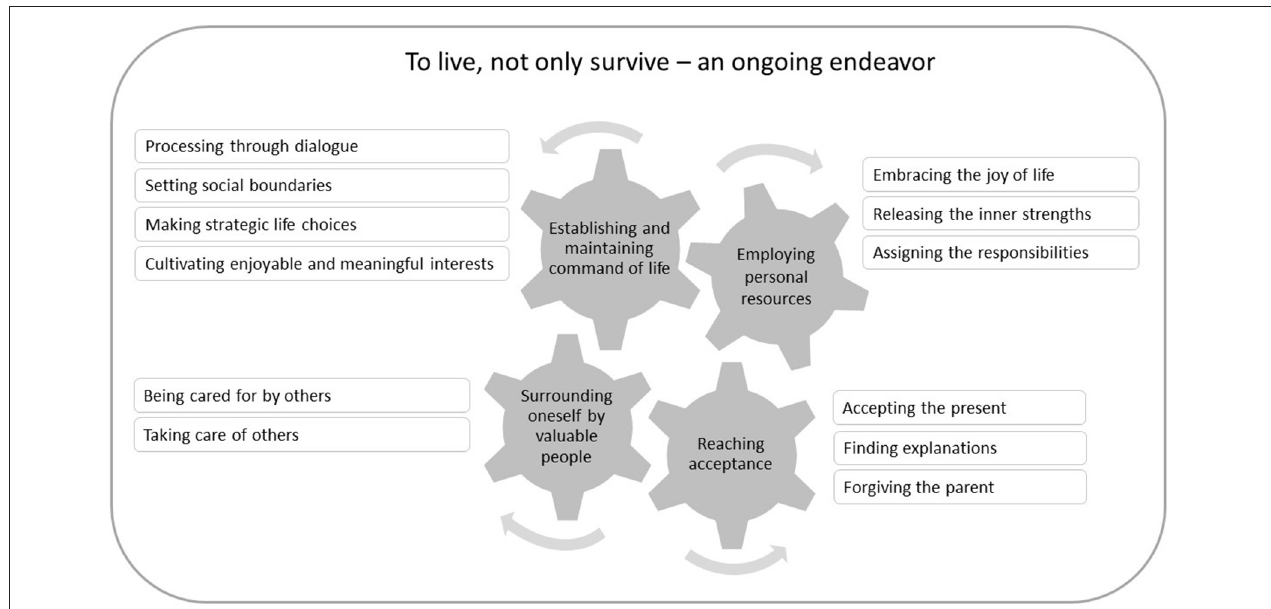
FIGURE 1 | Conceptualization of women’s experiences of processes of resilience in adulthood despite being exposed to maltreatment in